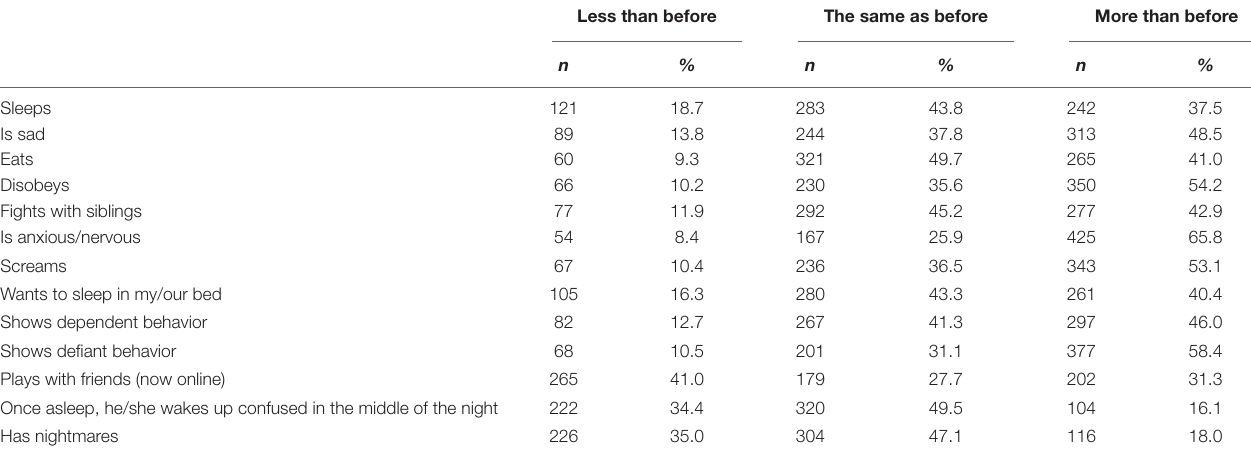
TABLE 2 | Frequency of behaviors behavior compared to pre-pandemic times and percentage of change in children’s behavior. Less than before The same as before More than before n